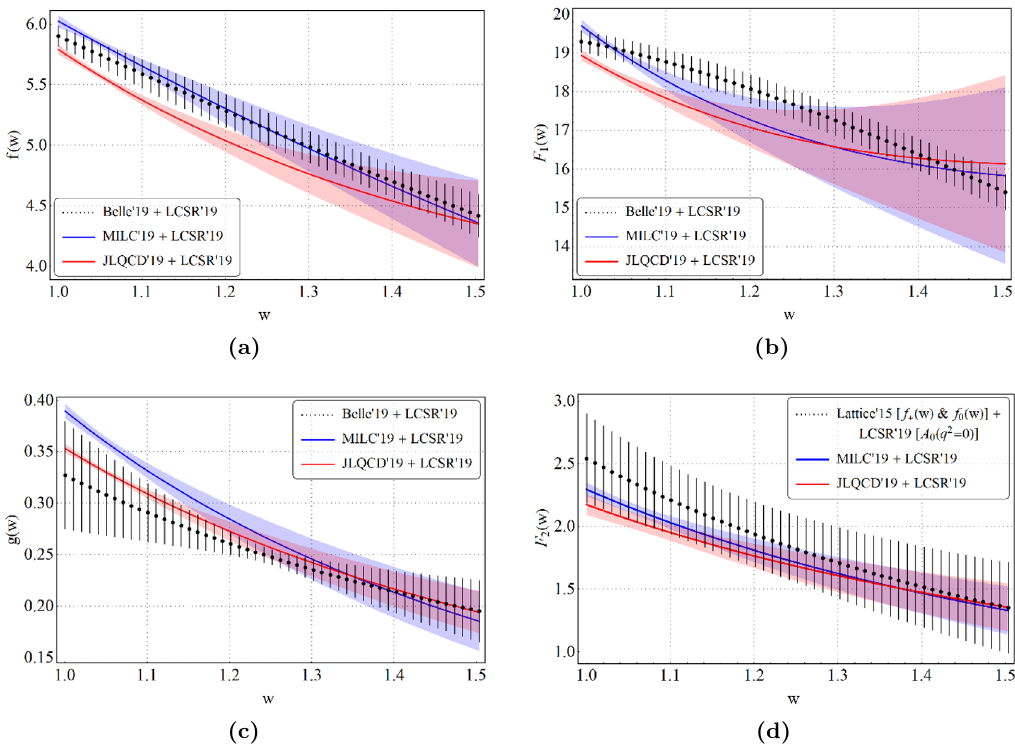
Figure 7. In (cid:12)gures 7a{7c, the shape of B ! D (cid:3) ‘(cid:23) ‘ BGL form factors for N = 2 obtained from the (cid:12)t to new Belle data [17] (black bars) is compared to that obtained with preliminary lattice inputs from MILC [32] (blue band) and with lattice inputs from JLQCD [33] (red band). In (cid:12)gure 7d, the blue and red bands hold the same meaning in context to F 2 while the black bars represent F 2 obtained using the method (involving LCSR inputs [21]) discussed in section 2.2.